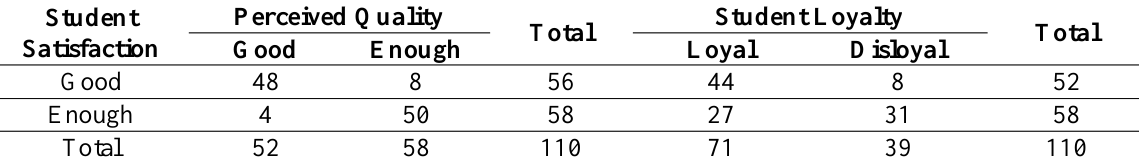
Table 3. Cross-tabulation result of Perceived Quality, Student Satisfaction, and Student Loyalty Student